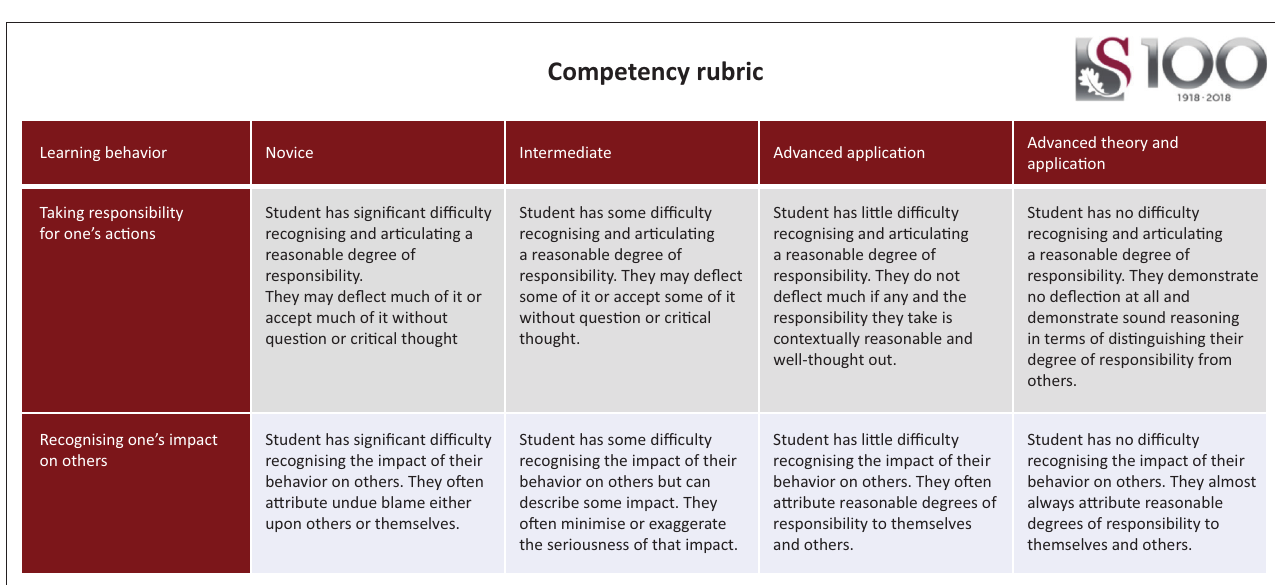
FIGURE 3: Competency framework for the Master of Divinity.